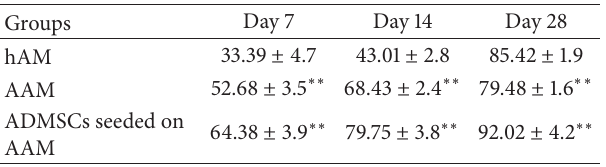
Table 1: Comparison of the wound healing rate between different